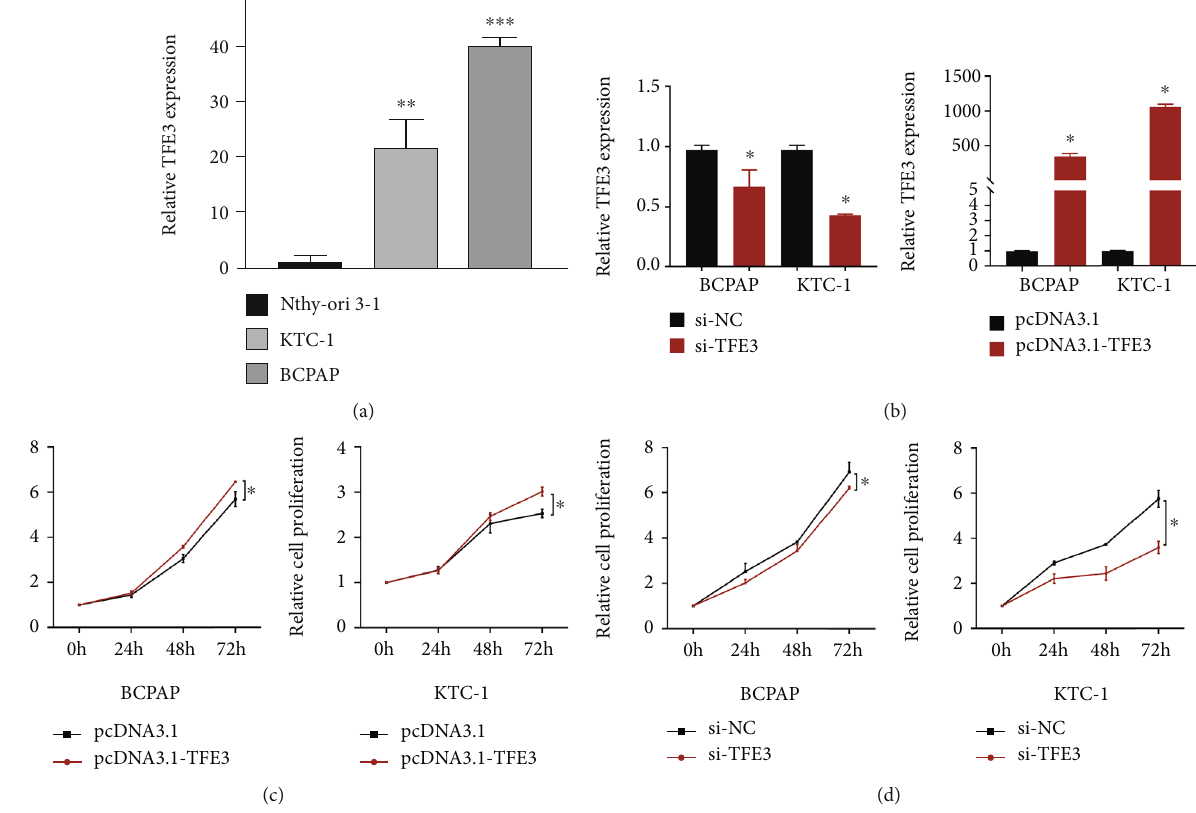
Figure 3: TFE3 promotes proliferation of PTC cells. (a) The expression of TFE3 in PTC cells was higher than that in Nthy-ori 3-1 ( ∗∗ P < 0 : 01 and ∗∗∗ P < 0 : 001 ). (b) After TFE3 transfection, the expression of TFE3 was detected by real-time PCR. (c) MTT assay showed that overexpression of TFE3 signi fi cantly increased the proliferation of BCPAP and KTC-1 cells ( ∗ P < 0 : 05 ). (d) MTT assay showed that knockdown of TFE3 decreased the proliferation of BCPAP and KTC-1 cells ( ∗ P < 0 : 05